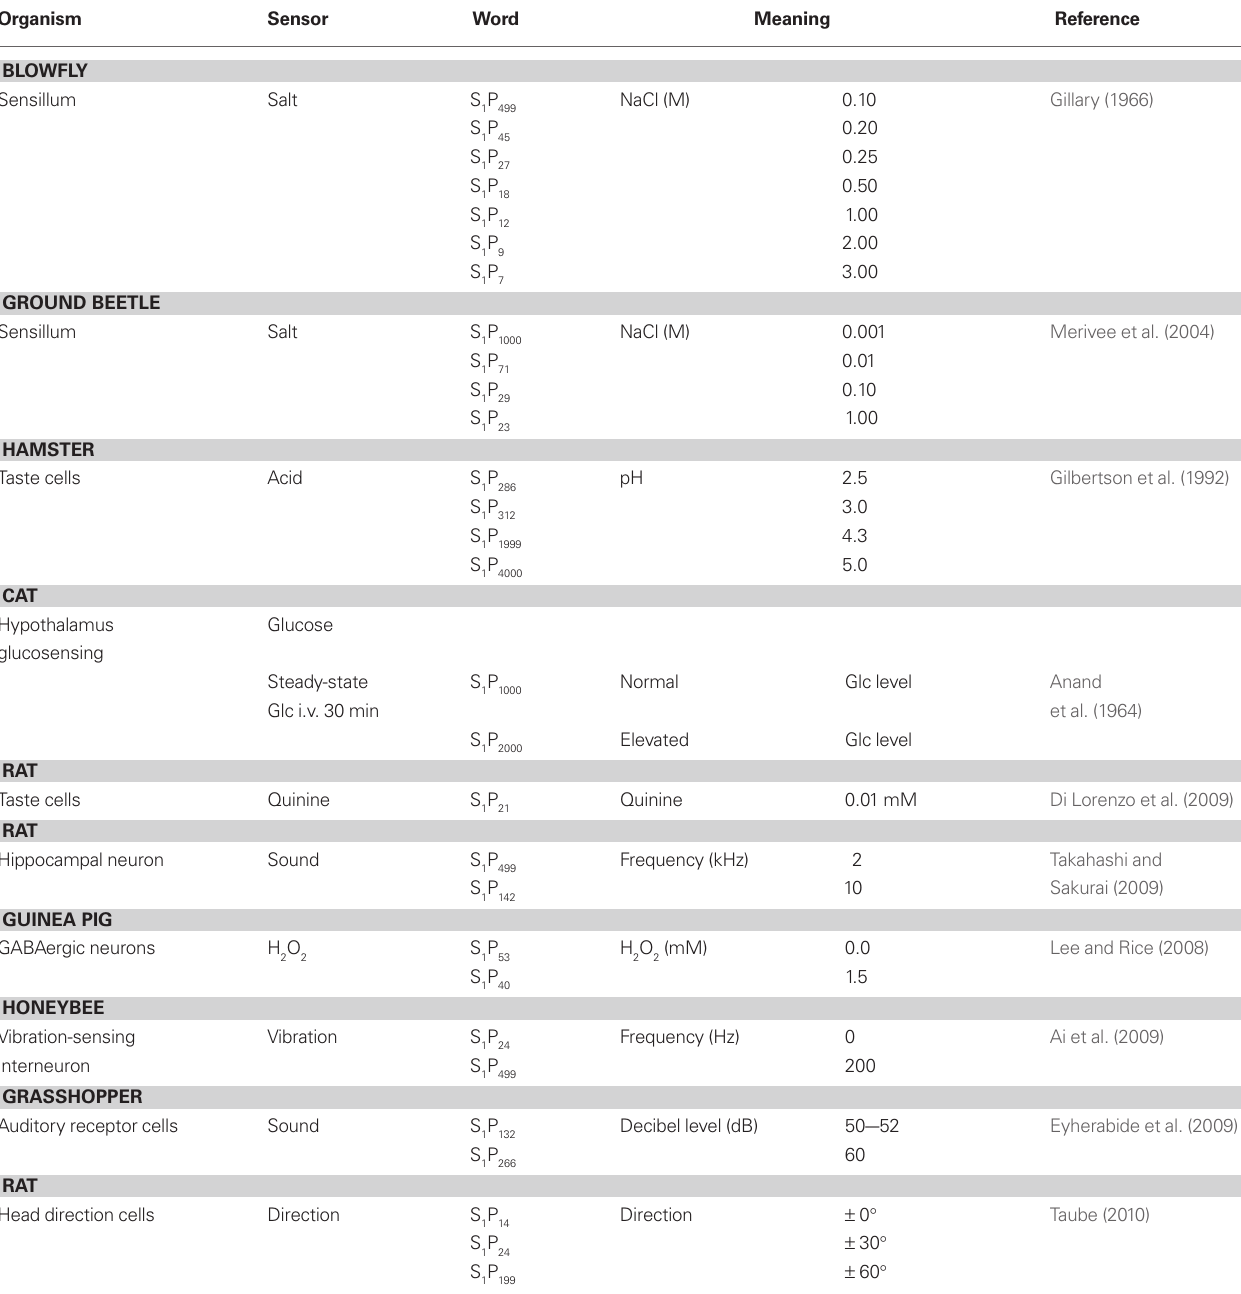
Table 1 | List of some neuronal S/P words and their meanings (adapted from Baslow, 2010a).